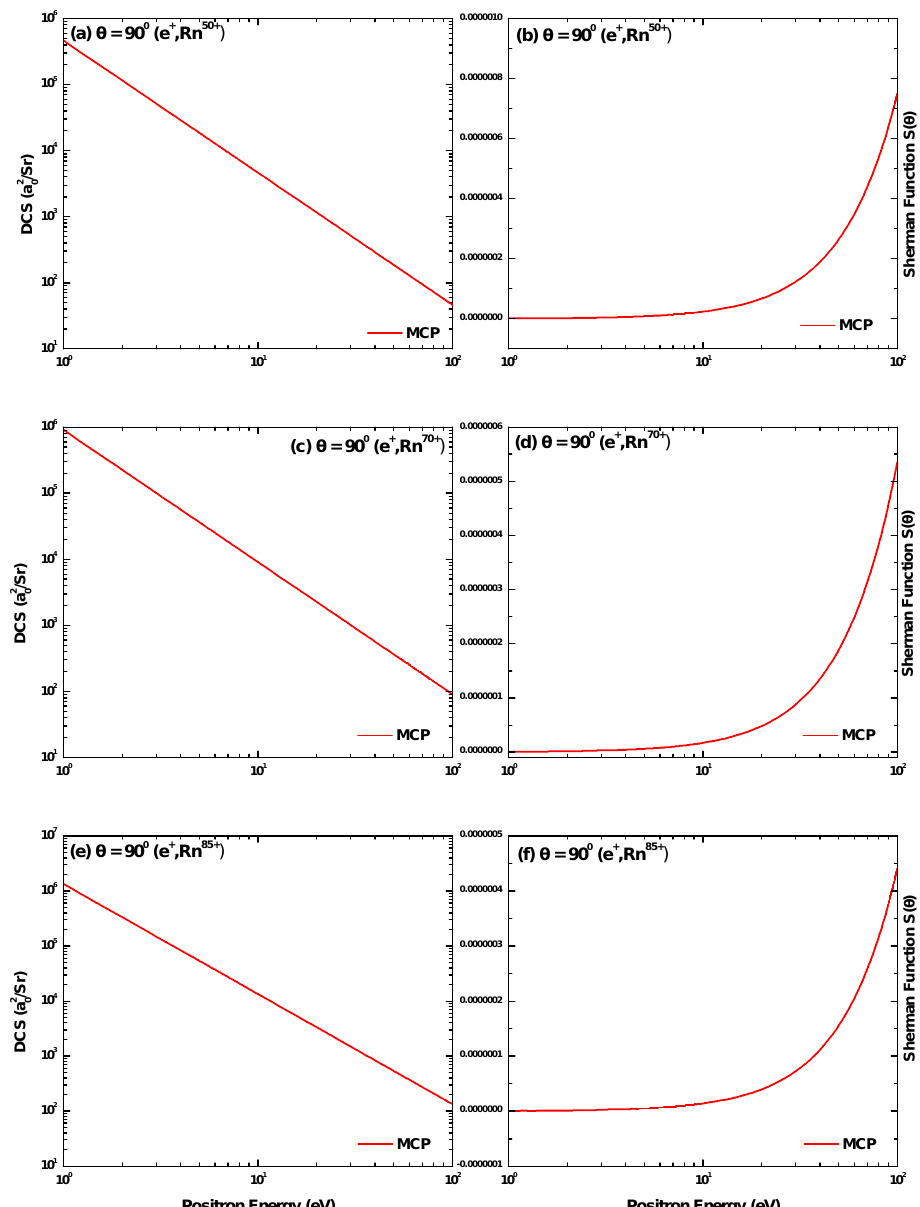
Figure 29. Energy dependent DCS and corresponding Sherman function for positrons elastically scattered from ( a , b ): Rn 50 + , ( c , d ): Rn 70 + and ( e , f ): Rn 86 + at fixed scattering angle θ = 90 ◦